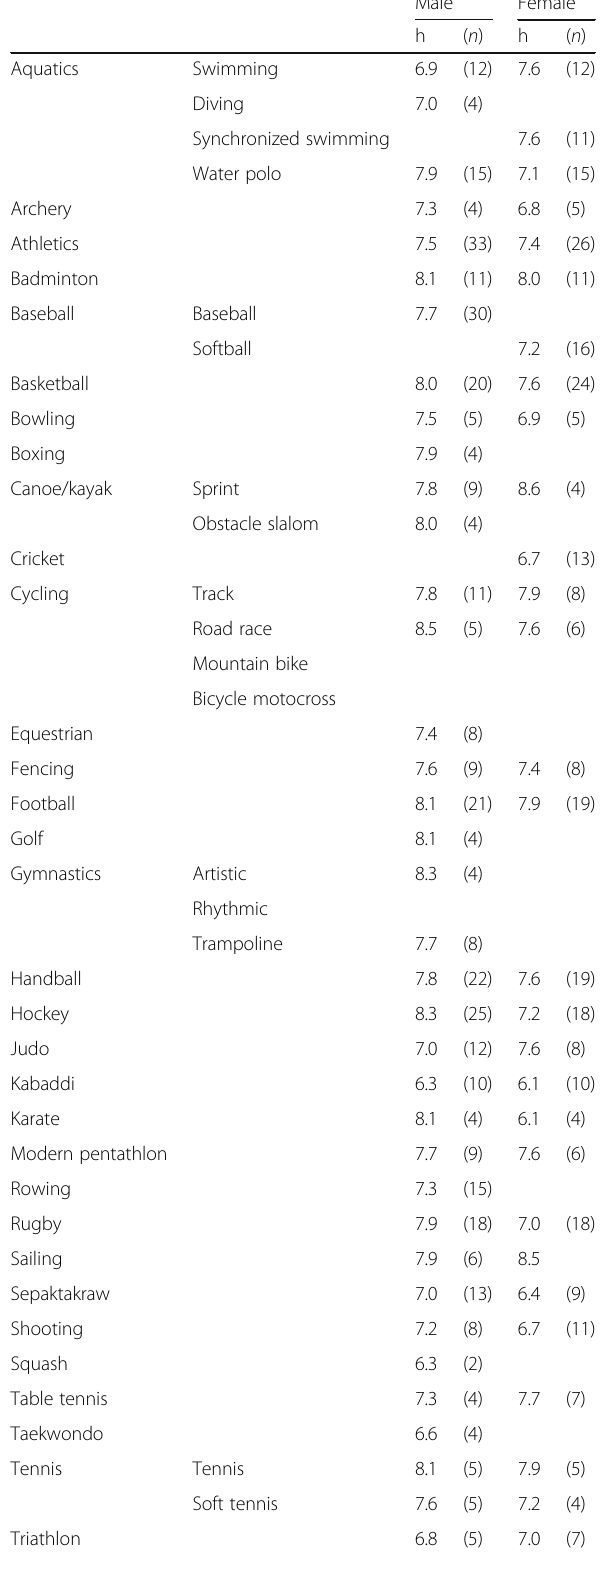
Table 2 The mean time in bed of athletes specialized in each sport